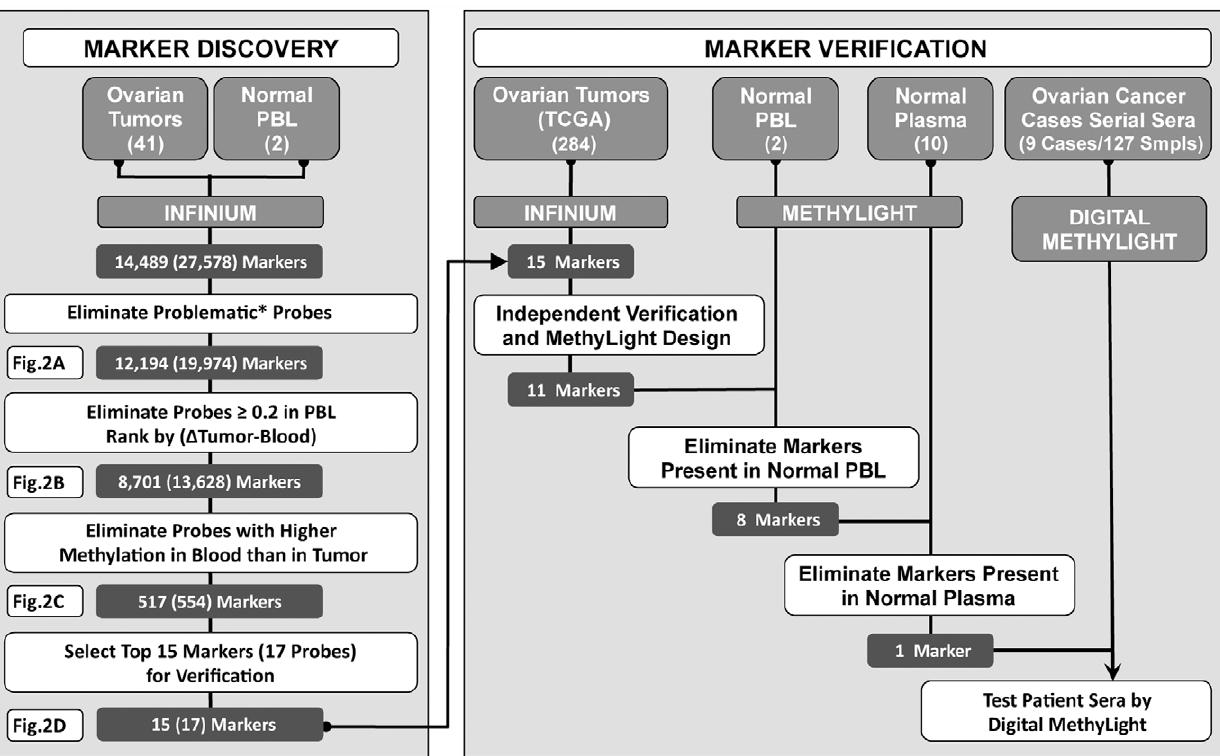
Figure 1. Schematic representation of the ovarian cancer marker discovery and verification pipeline. The Infinium platform was used to screen 27,578 probes representing 14,489 individual gene loci. We used a systematic stepwise approach to eliminate probes that failed in any of the samples, probes that contained SNPs or repeat sequences, or probes with a beta value higher than 0.2 in any of the PBL samples. The remaining probes were ranked based on their difference between tumors and blood (see Materials and Methods), and the probes with higher DNA methylation in PBL than in any of the tumor samples were eliminated. The top 15 from the remaining 517 markers were transitioned to the MethyLight platform for further verification. All 15 markers passed an independent verification test performed on publically available TCGA ovarian cancer dataset and additional PBL samples. Three markers failed due to incompatibility issues related to the MethyLight platform, while another ten failed because they were methylated in normal PBL DNA (3 markers) or normal plasma (7 markers). Only one marker, IFFO1 , was selected for further verification on patient samples using Digital MethyLight. (The asterisk indicates probes that failed in any of the samples, as well as those that included SNPs and repeat sequences).